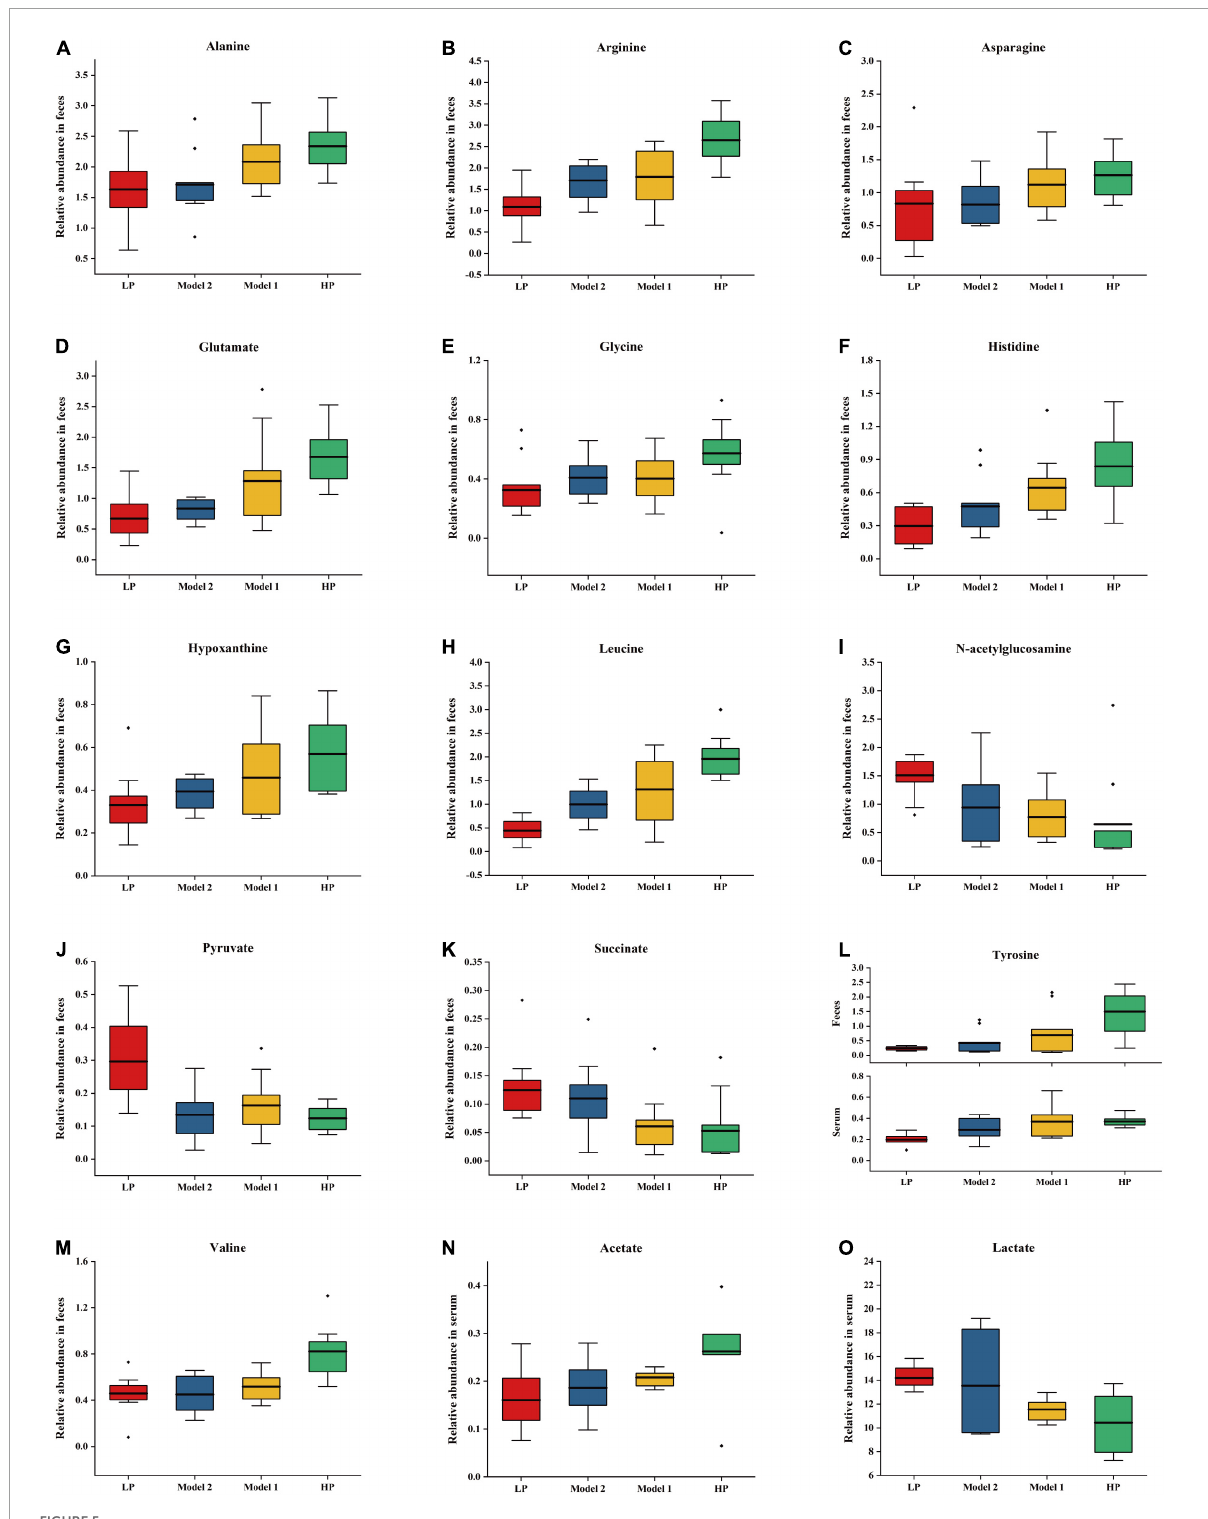
FIGURE5 Correlation difference metabolite normalized peak area box plots for Model 1, Model 2, chronic low protein, and chronic high protein diet model groups. (A) Alanine, (B) arginine, (C) asparagine, (D) glutamate, (E) glycine, (F) histidine, (G) hypoxanthine, (H) leucine, (I) N-acetylglucosamine, (J) pyruvate, (K) succinate, (L) tyrosine, (M) valine, (N) acetate, and (O) lactate. Data are expressed as mean ±